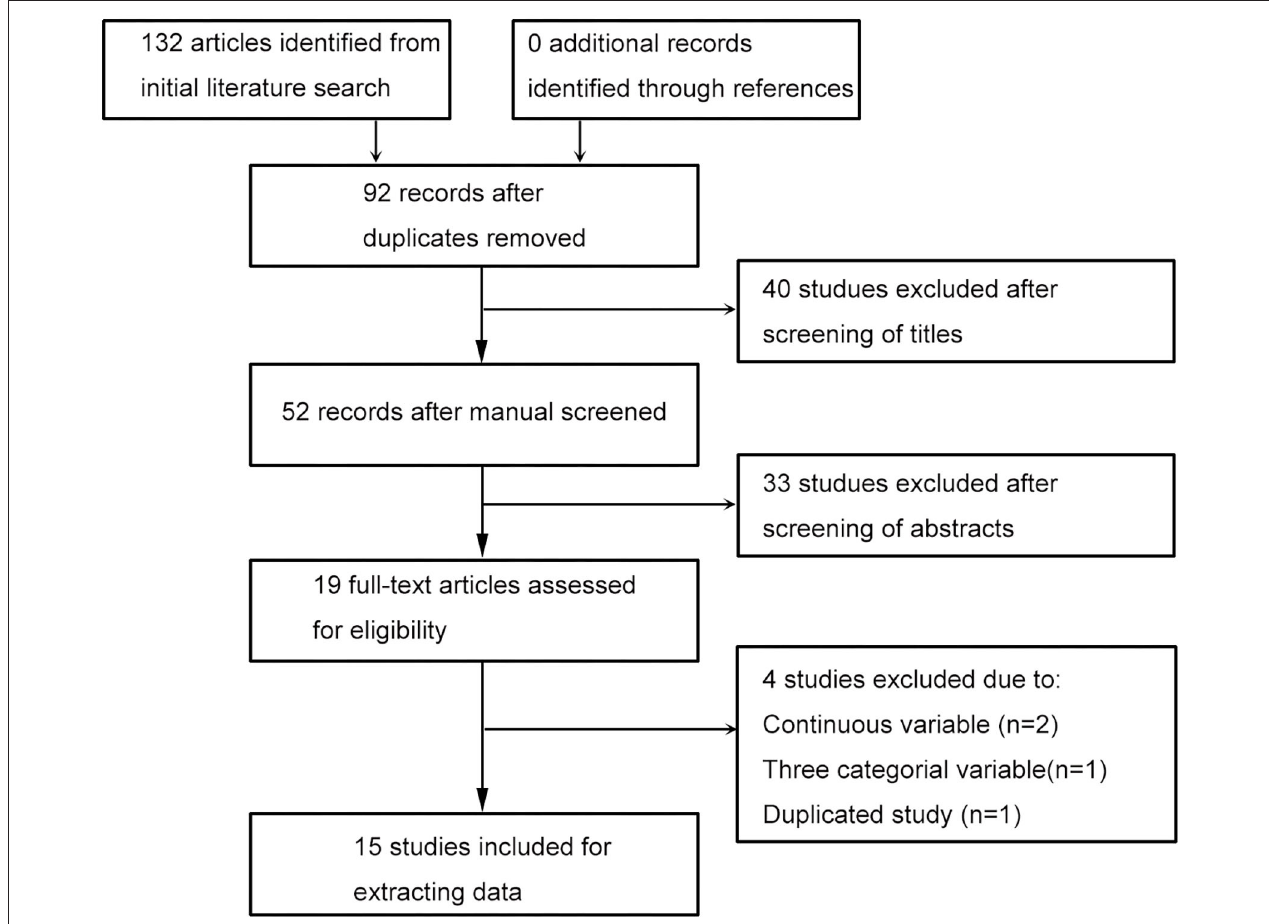
FIGURE 1 | The flow diagram of literature